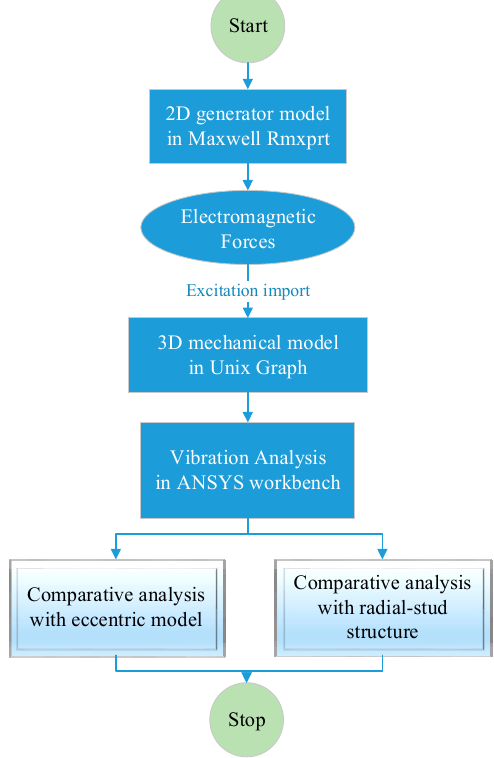
Figure 6. Schematic procedure of finite element (FE) analysis.